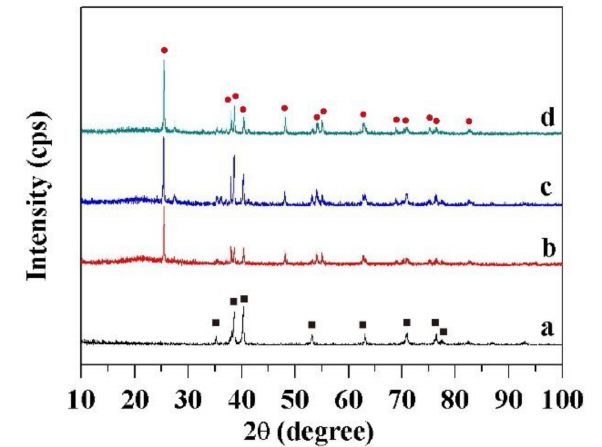
Figure 3. XRD patterns of Ti substrates. Symbol identification: ( a ) the pristine mesh, ( b ) the superhy- drophilic mesh, ( c ) the superhydrophobic mesh, and ( d ) the UV-irradiated superhydrophilic